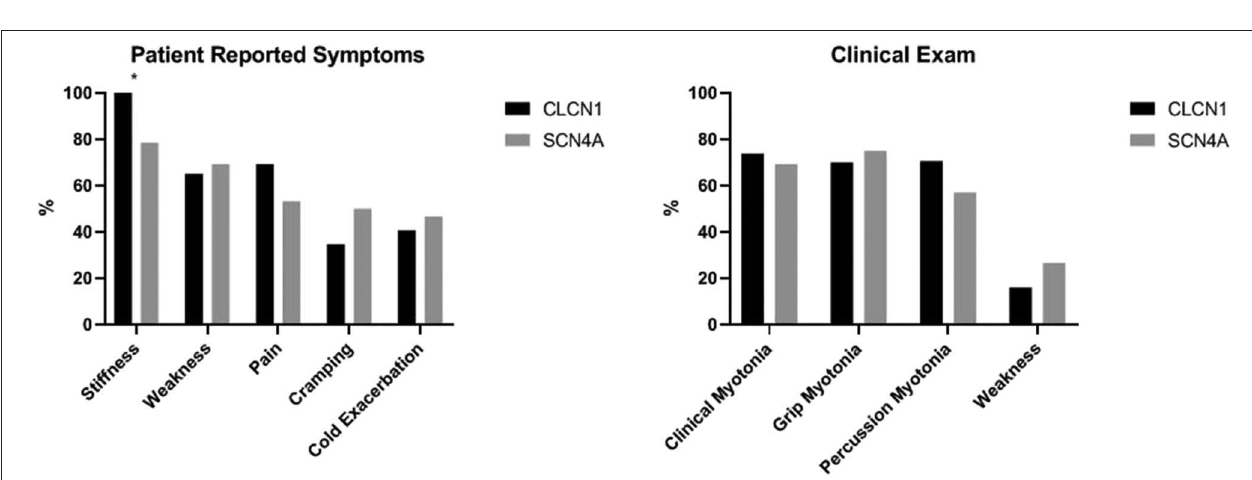
FIGURE 6 | Comparison of patient reported symptoms and clinical examination between patients with variants in CLCN1 and SCN4A . Asterisks indicate areas with statistically significant differences. Patients with CLCN1 variants were more likely to report stiffness than those with SCN4A variants ( p =